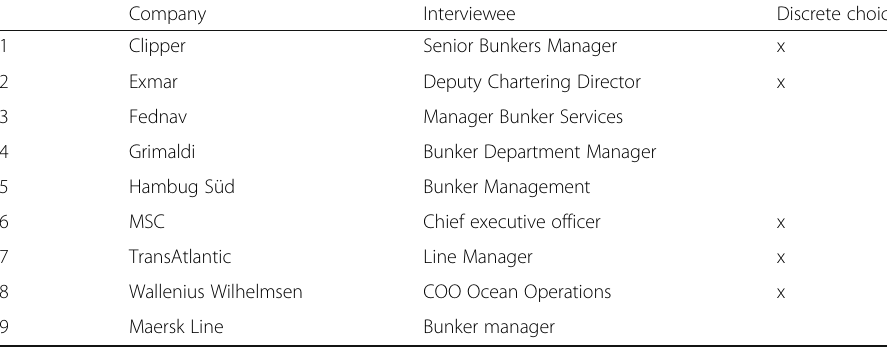
Table 5 Overview of contributing